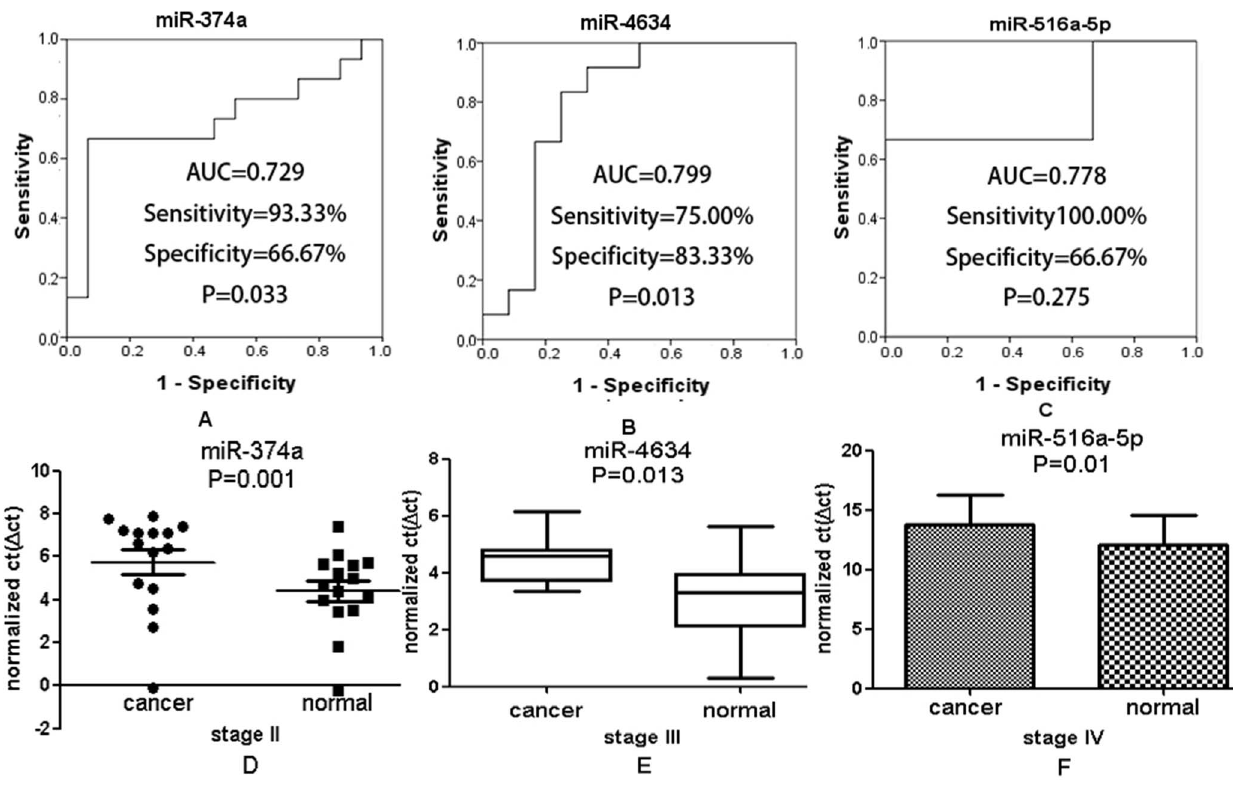
Figure 3. Evaluation of the potential of miR-374a, miR-4634, miR-516a-5p as diagnostic biomarkers in clinical application. Among them, miR-374a was dysregulated in stage II, miR-4634 was related to lymph node metastasis in stage III, and miR-516a-5p might be associated with distant metastasis.